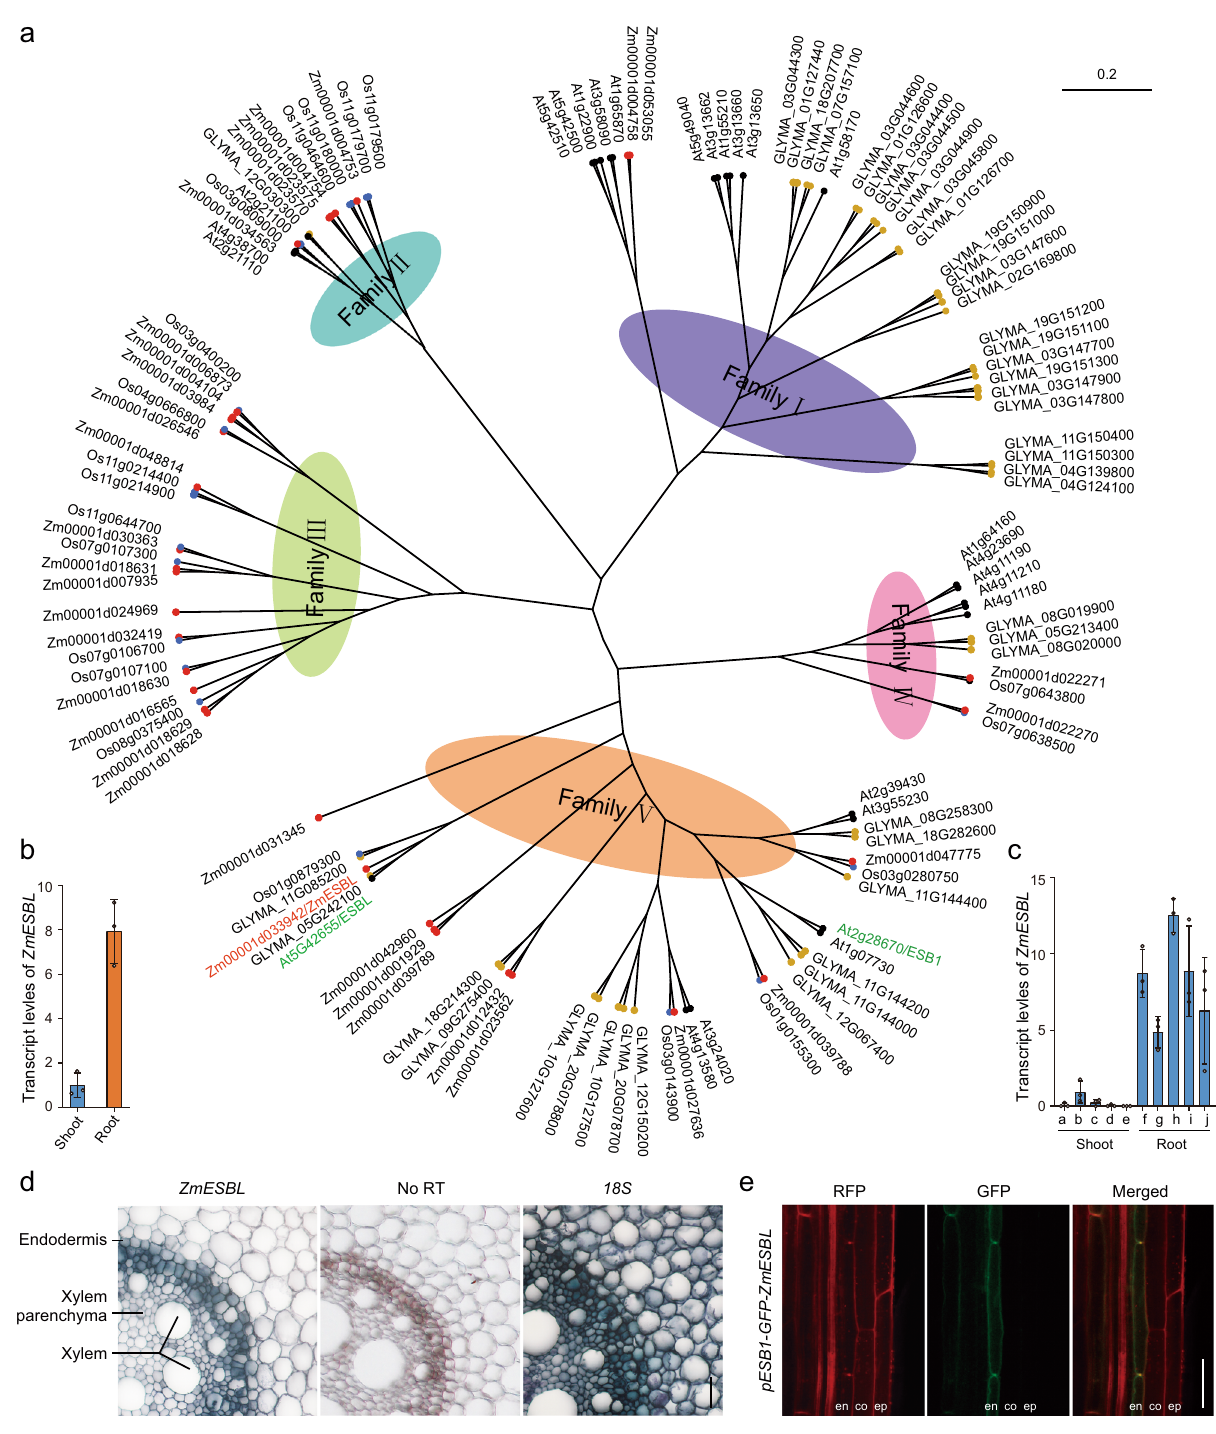
Fig. 3 Phylogenetic analysis, expression pattern and the subcellular localization of Zm00001d033942/ZmESBL. a The phylogenetic tree for maize, rice, soybean and Arabidopsis DIR proteins. b The transcript levels of ZmESBL in root and shoot tissues. c The transcript levels of ZmESBL in indicated samples. The data was downloaded from MaizeGDB a, 6 – 7 internode; b, 7 – 8 internode; c, leaf zone 1; d, leaf zone 3; e, mature leaf 8; f, root meristem zone; g, root elongation zone; h, root cortex; i, primary root; j, secondary root. d The in-situ RT-PCR assay. The dark blue signal indicated the presence of ZmESBL transcripts. No reverse transcription (No RT) and the 18S rRNA ( 18S ) provided controls. e The subcellular location of GFP-ZmESBL protein in the Arabidopsis plants transformed with pAtESB1-GFP-ZmESBL . The red fl uorescence indicated the basic fuchsin staining of lignin. The results in ( b ) were means ± s.d. of three independent experiments. The images in ( d ) and ( e ) were representative of three independent repeats with similar results. Bars in ( d ) and ( e ), 20 μ m. Source data are provided as a Source Data fi